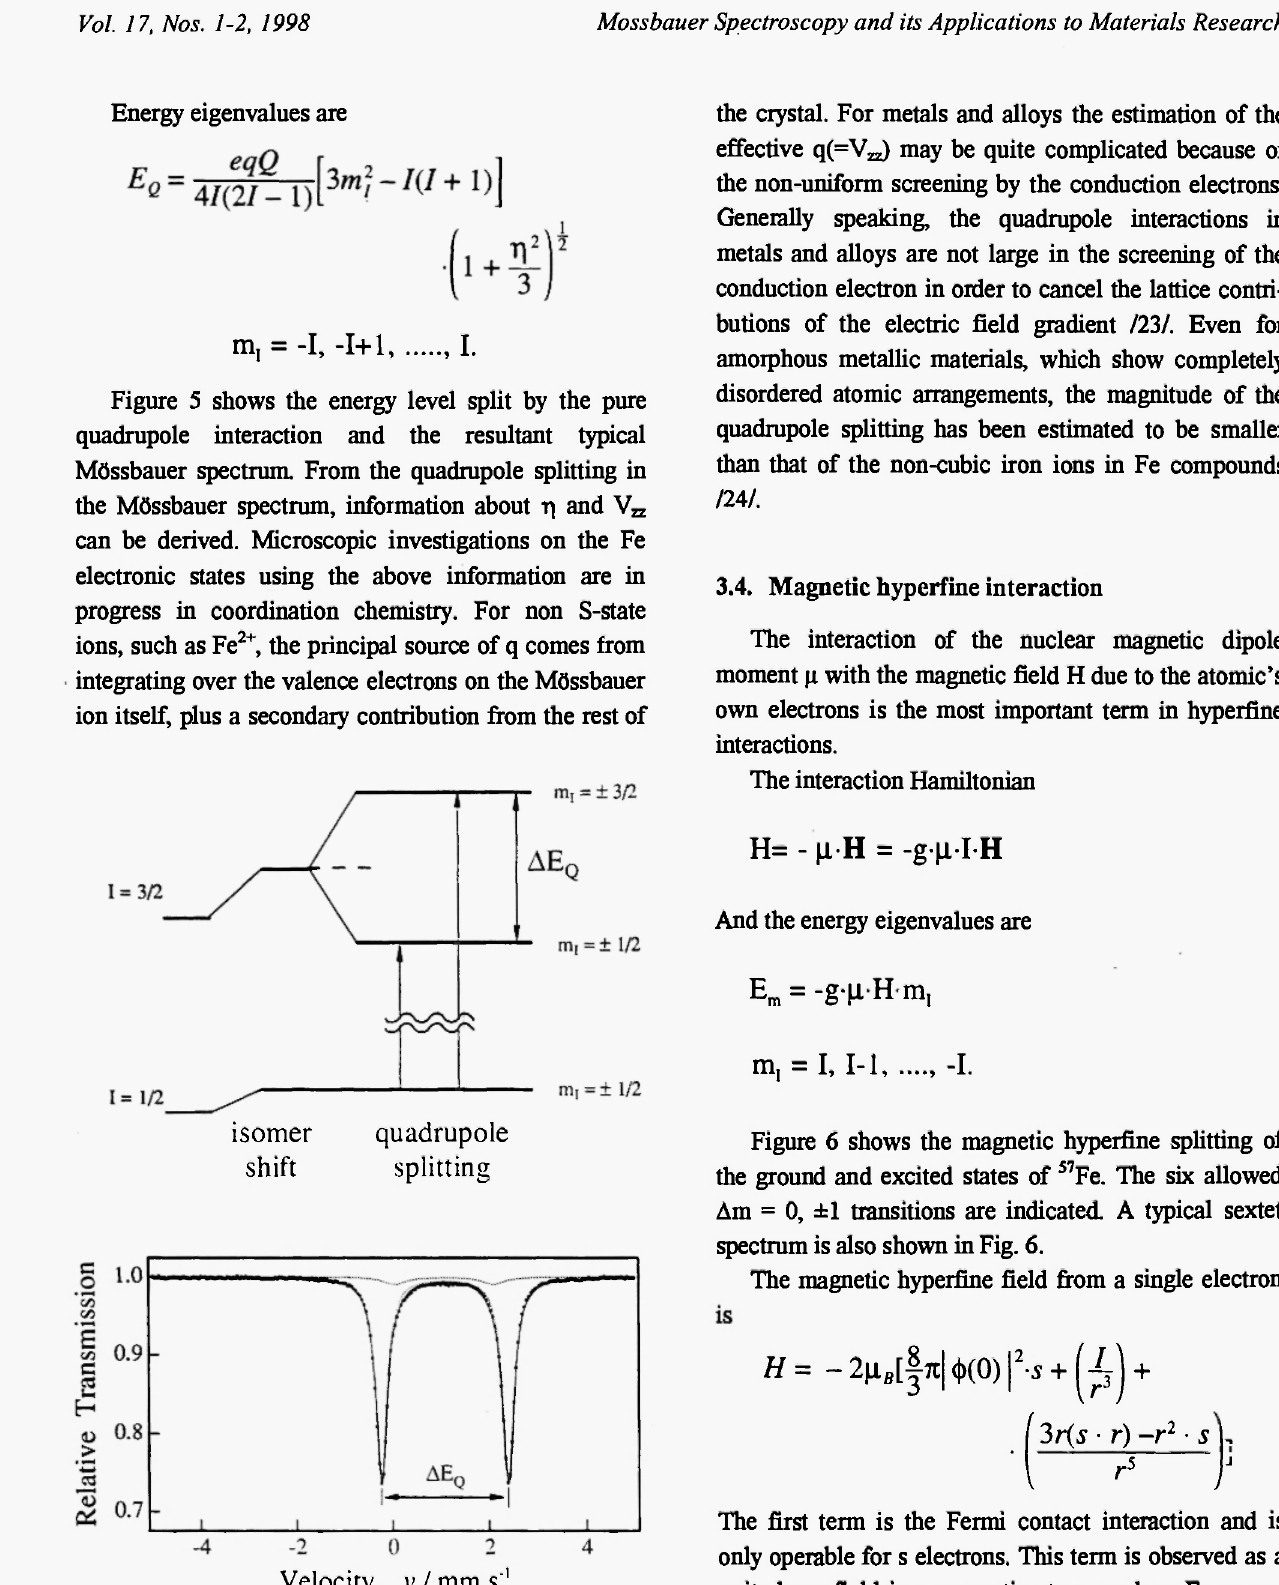
Si0 at 2 4 was prepared 4